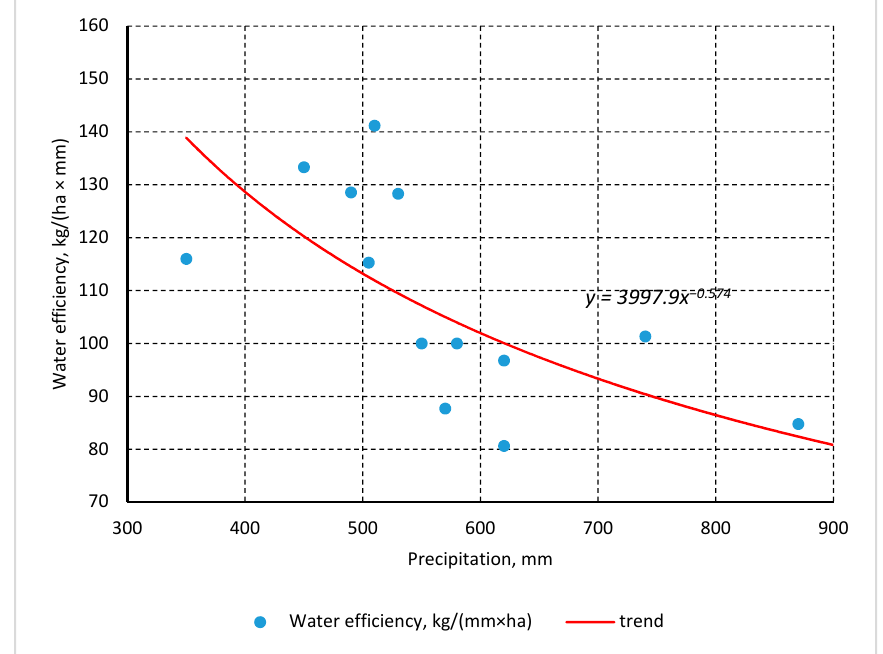
Figure 10. Water use efficiency for sweet sorghum.